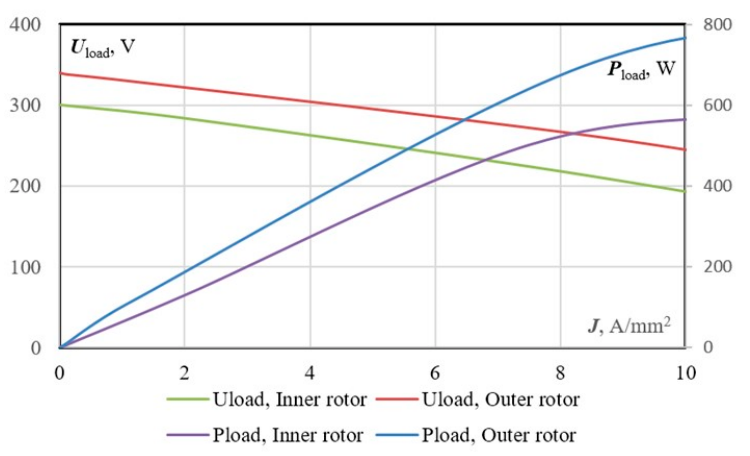
Figure 14. Terminal voltage and output power characteristics of the three-phase 3D FEM TFM models with outer and inner rotors.